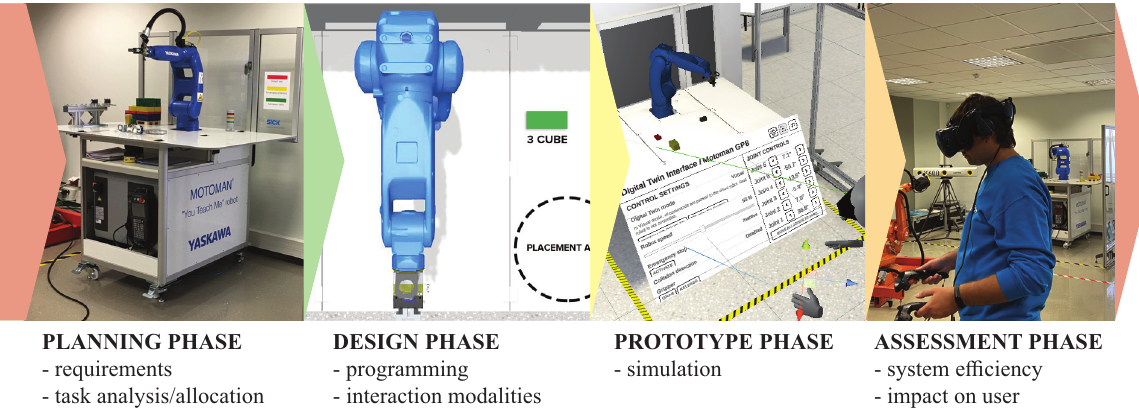
Fig. 2. Use case scenario of UCD approach in HRC making use of DT AR/VR